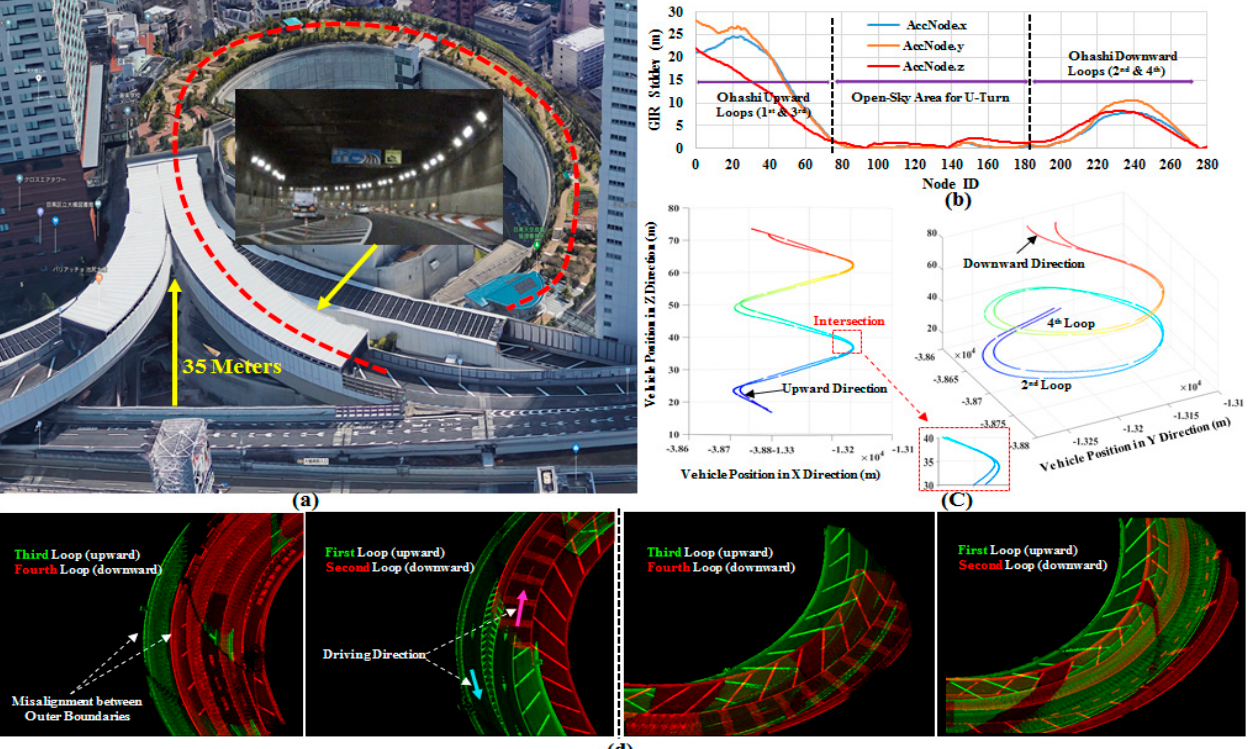
Figure 12. Mapping multilevel Ohashi Junction in Tokyo. ( a ) Rood structure ranging from 30m underground to 35m aboveground using four loops. ( b ) GIR accuracy in X, Y and Z directions indicating a big difference between upward and downward loops. ( c ) Upward loops have been intersected with downward loops by GIR instead to be interfered with around 10m relative positions in the Z direction (the change of color demonstrates the change of height). ( d ) GIR map images in the same xy coordinates in each pair showing the intersections between layers representing road surfaces in opposite directions at the same elevation level.